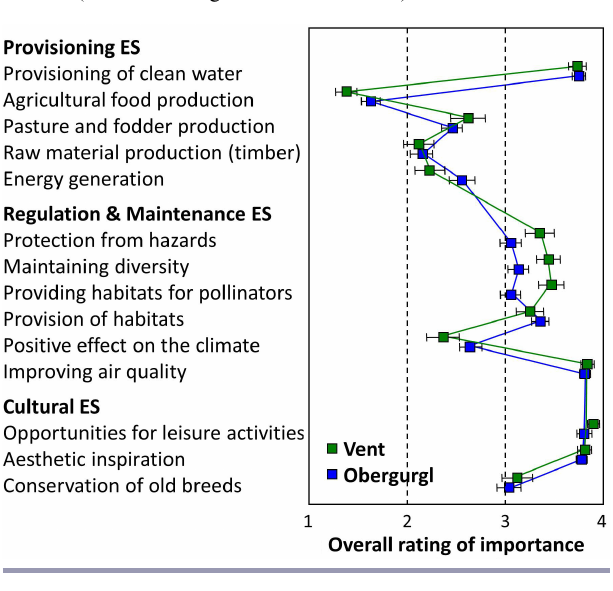
Fig. 3 . Mean perceived ecosystem service (ES) supply based on the existing natural capital of the most relevant ES in the study areas. Values range from 1 (not important) to 4 (very important). Ecosystem services were classified according to CICES (Haines-Young and Potschin